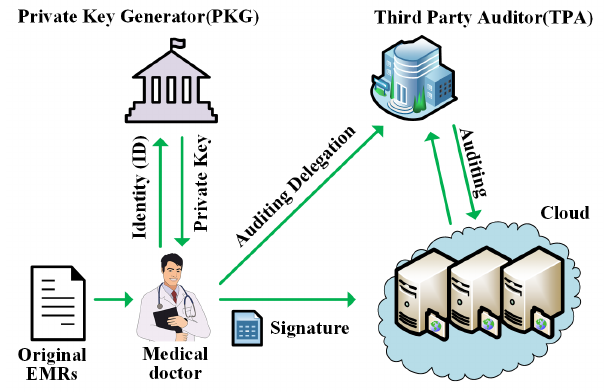
Figure 1. An example of a healthcare service